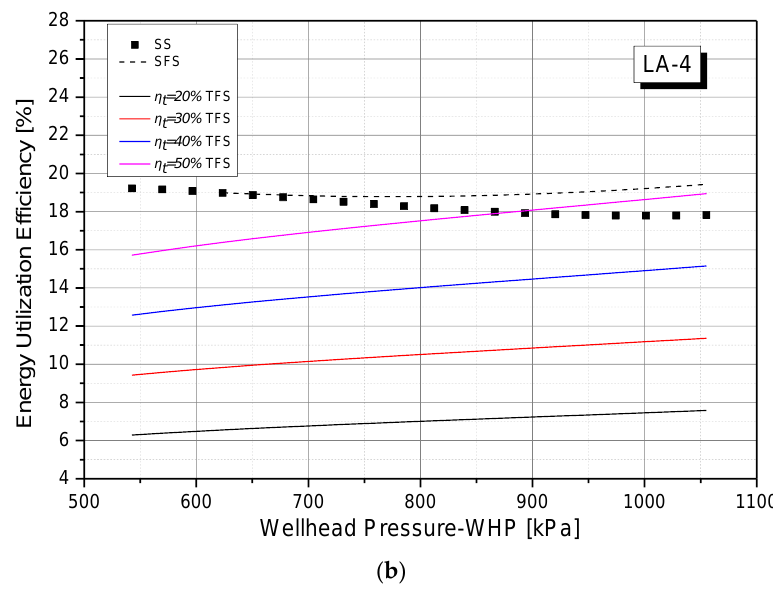
Figure 5. Energy utilization efficiency against wellhead pressure of ( a ) LA-8 and ( b ) LA-4.